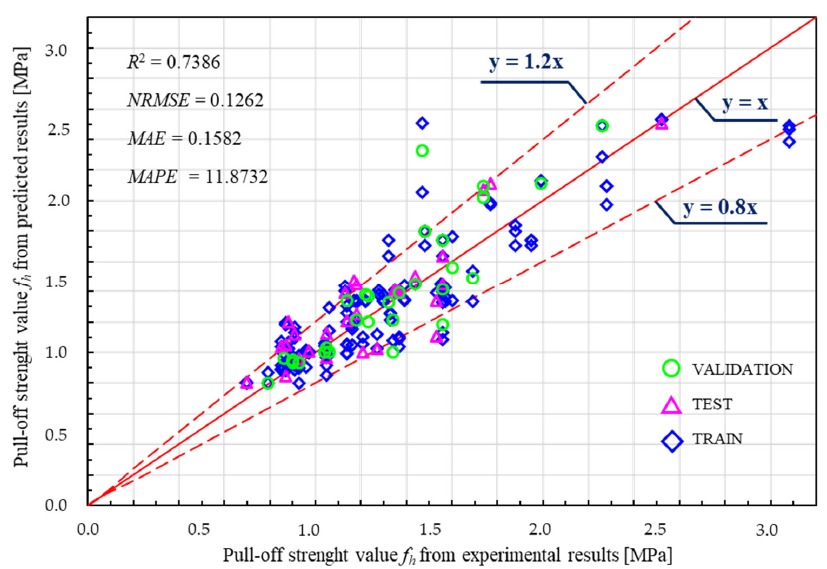
Figure 11. Relationship between the predicted value and the experimental value of the pull-off strength f h for ANN test, train, and validation process for the GD algorithm with two layers of hidden neurons.